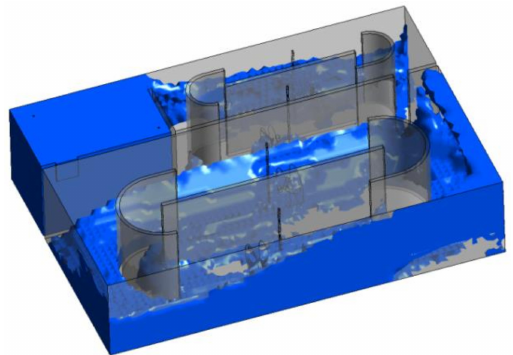
Figure 9. Sludge deposit area.